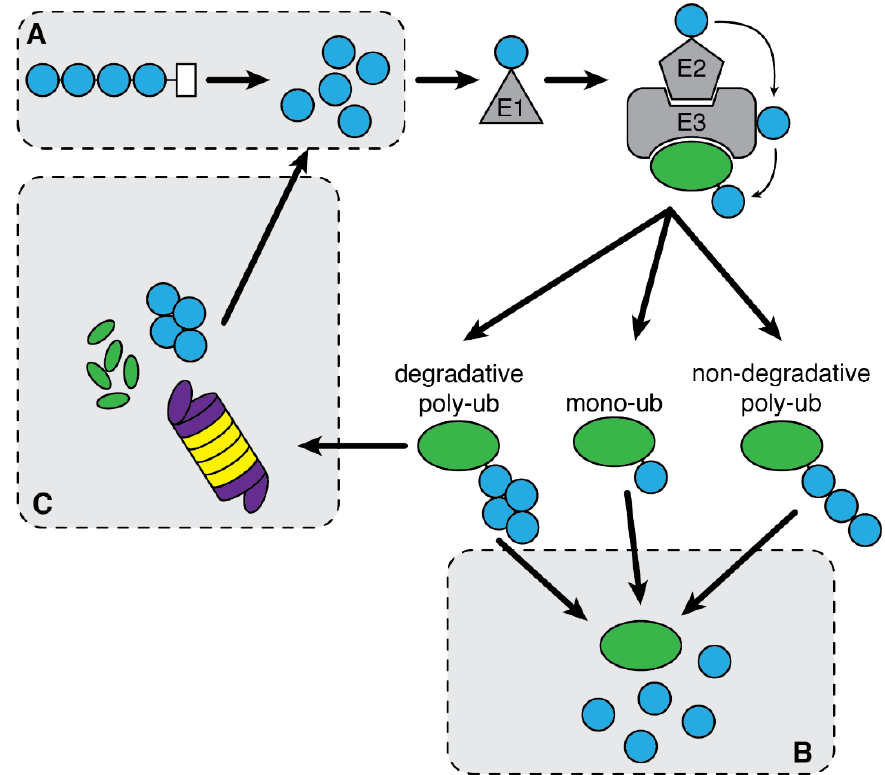
Figure 2. Localization of the action of DUBs in the ubiquitination process. Ubiquitination is catalyzed by three types of enzymes: E1, E2, E3. It is a reversible reaction. DUBs process ubiquitin chains at three level: ( A ) For the generation of ubiquitin monomers from a ubiquitin precursor; ( B ) for the selective removal of ubiquitin moieties on ubiquitinated proteins; and ( C ) for the recycling of ubiquitin from protein degraded by the proteasome.